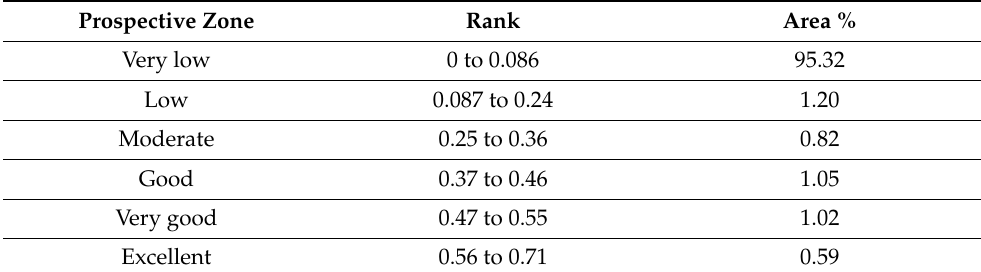
Figure 9. ( a ) Mineral prospective map; ( b ) quartz dike cuts older granites, surrounds with argillic alteration and extends ~N-S; ( c ) Sir Bakis mine; ( d ) silicified zone cuts metasediments (MS) and younger granite (YG); ( e ) wadi deposits surrounded by younger granites (YG), metavolcanics (MV), and metasediments (MS); ( f ) Aplite dike and associated argillic alterations. Table 4. Mineral prospective map.